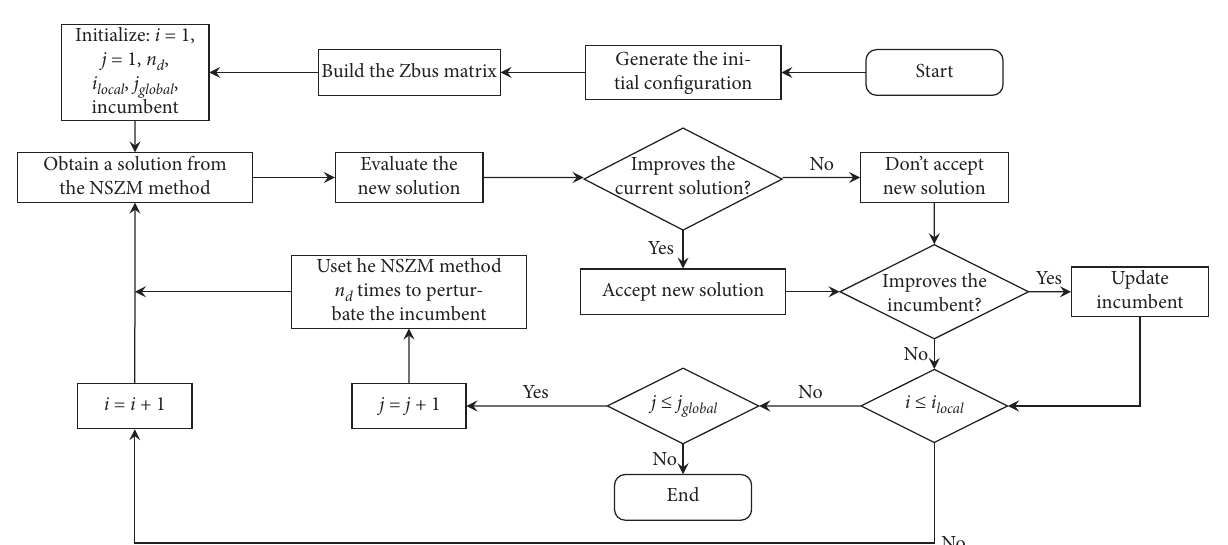
Figure 4: Flowchart of the